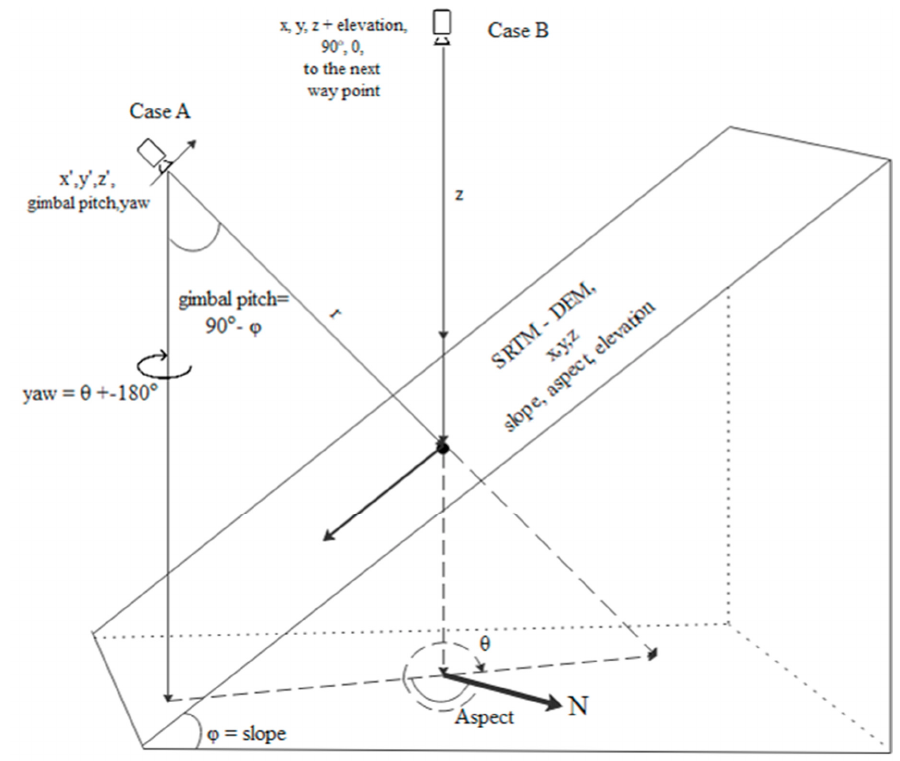
Figure 3. Description of position of the projected image centers in case A and case B, in relation to the